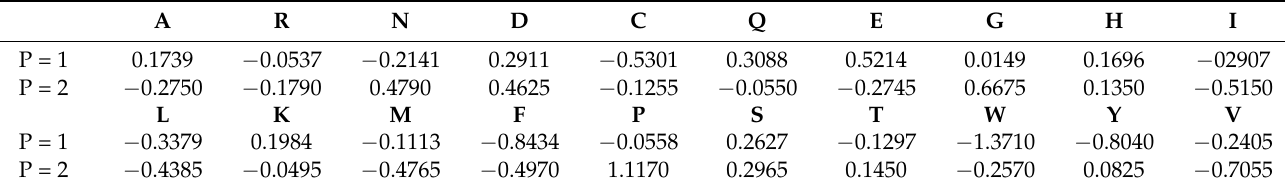
Table 2. Mapping values of amino acid sequences according to p -th